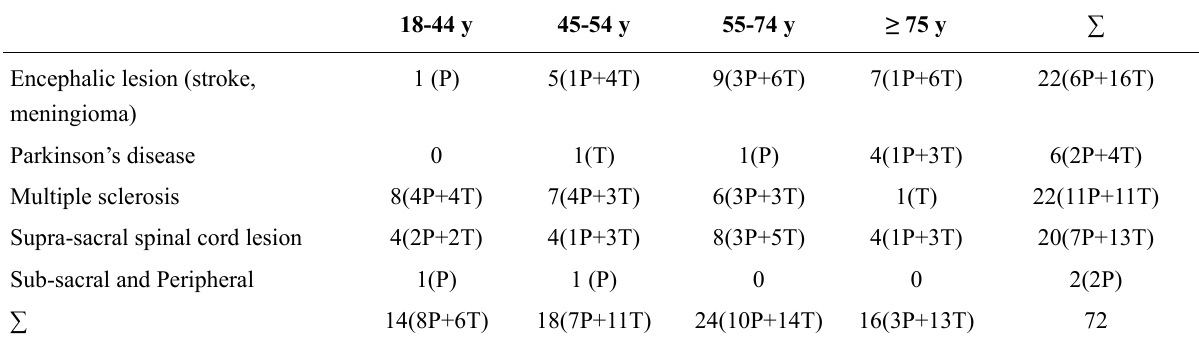
Table 1 - Description of the DO population with a history of neurological disease. In each age-group, the number of patients is presented as total (a) and in parentheses bP and cT DO: